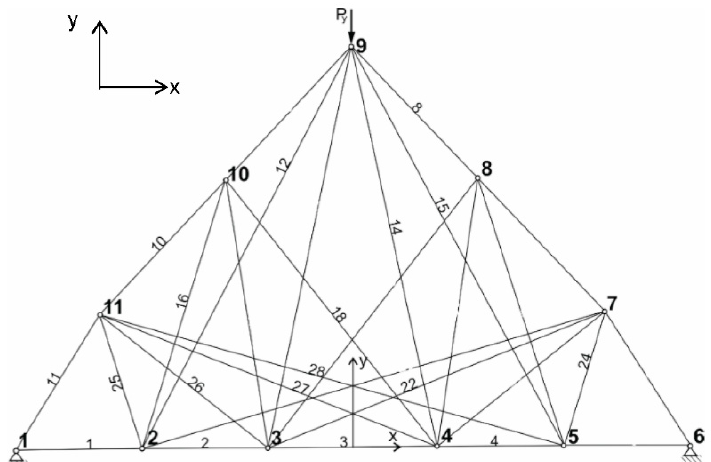
Figure 5. 29 bar structure—initial configuration.